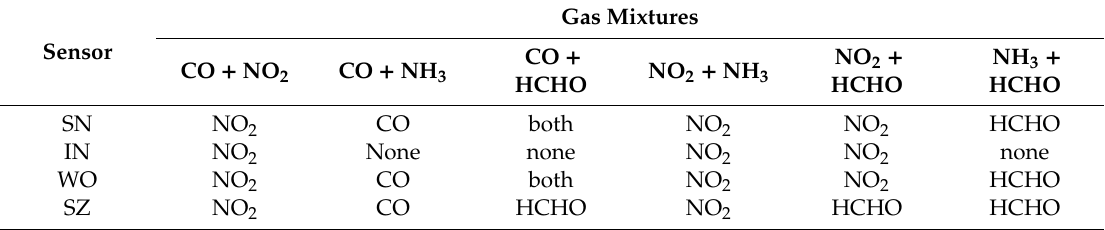
Table 1. Chemiresistive responses of each individual sensor to the two-component mixed gas systems.